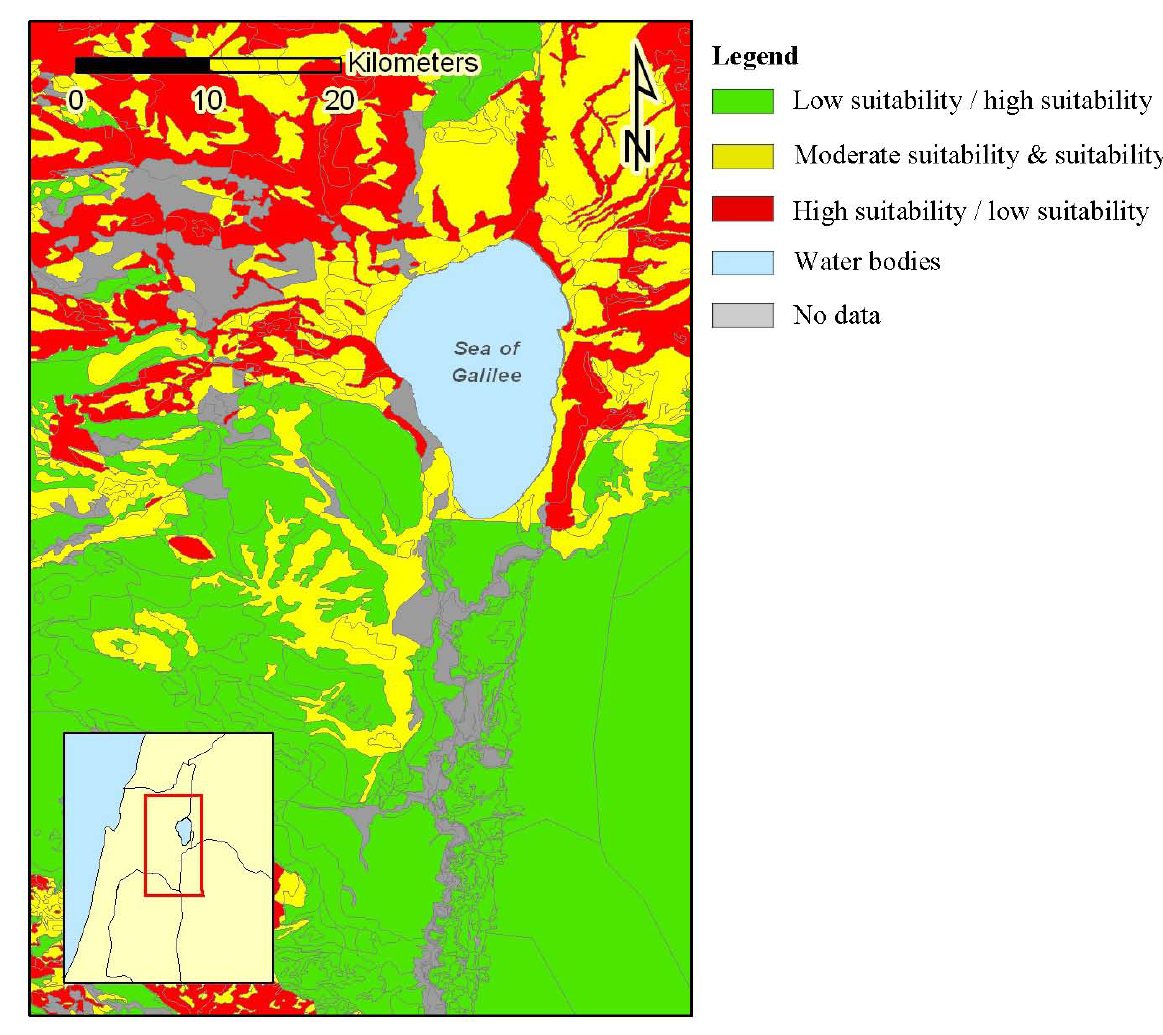
Figure 6. Cut-out of the assessment map visualizing sensitivity E: Sensitivity towards groundwater pollution (scale 1: